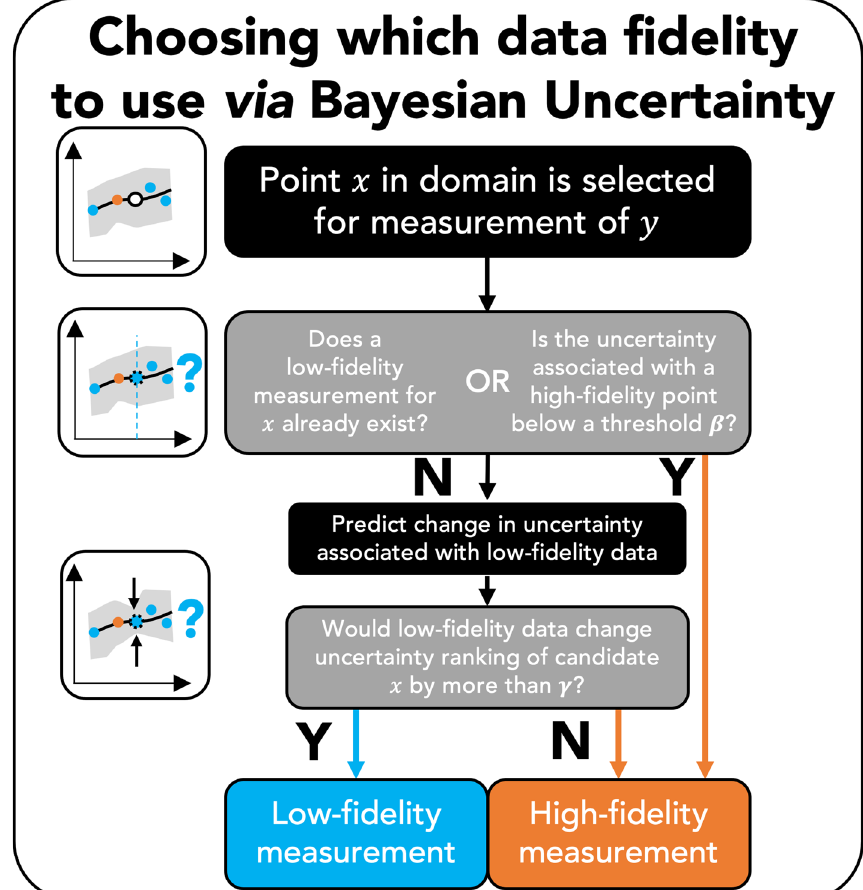
Figure 3. Overview of how uncertainty is used to balance the use of low and high fidelity data in the implementation of Algorithm 2 of Section S2. When a data point x is called for as an experimental candidate, the above flowchart describes the decision-making process for which data source to use. After a data point x is selected for measurement, two conditions are checked: (1) if the corresponding (e.g. with the same formula) low-fidelity measurement has already been made or (2) if the uncertainty associated with the high fidelity measurement is low enough (below a threshold β ). If either is true, the high-fidelity measurement is taken. If neither are true, then the agent must consider the trade-off between low-fidelity and high-fidelity data. The agent thus considers how a low fidelity data point would affect the current ordering of the predicted figure of merit associated with all candidates. If it would alter the ranking by more than γ , the low-fidelity measurement is taken. If not, the high-fidelity measurement is taken. Note that β and γ are user-defined hyperparameters explained in detail in Section